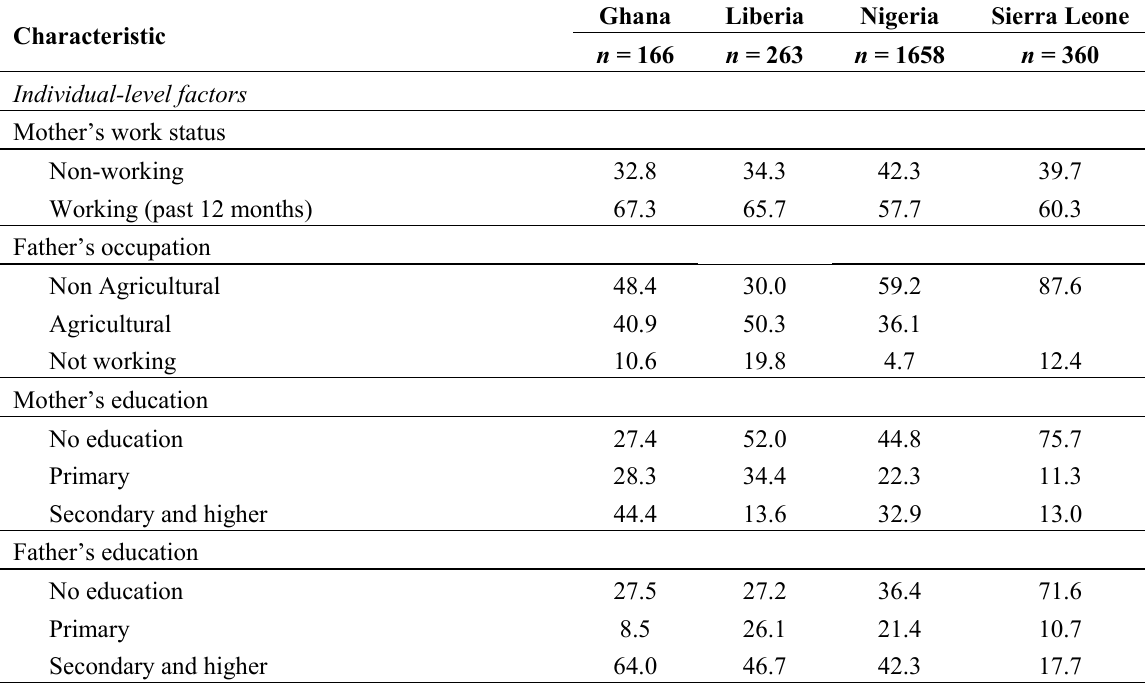
Table 1. Individual-, household- and community-level characteristics of infants